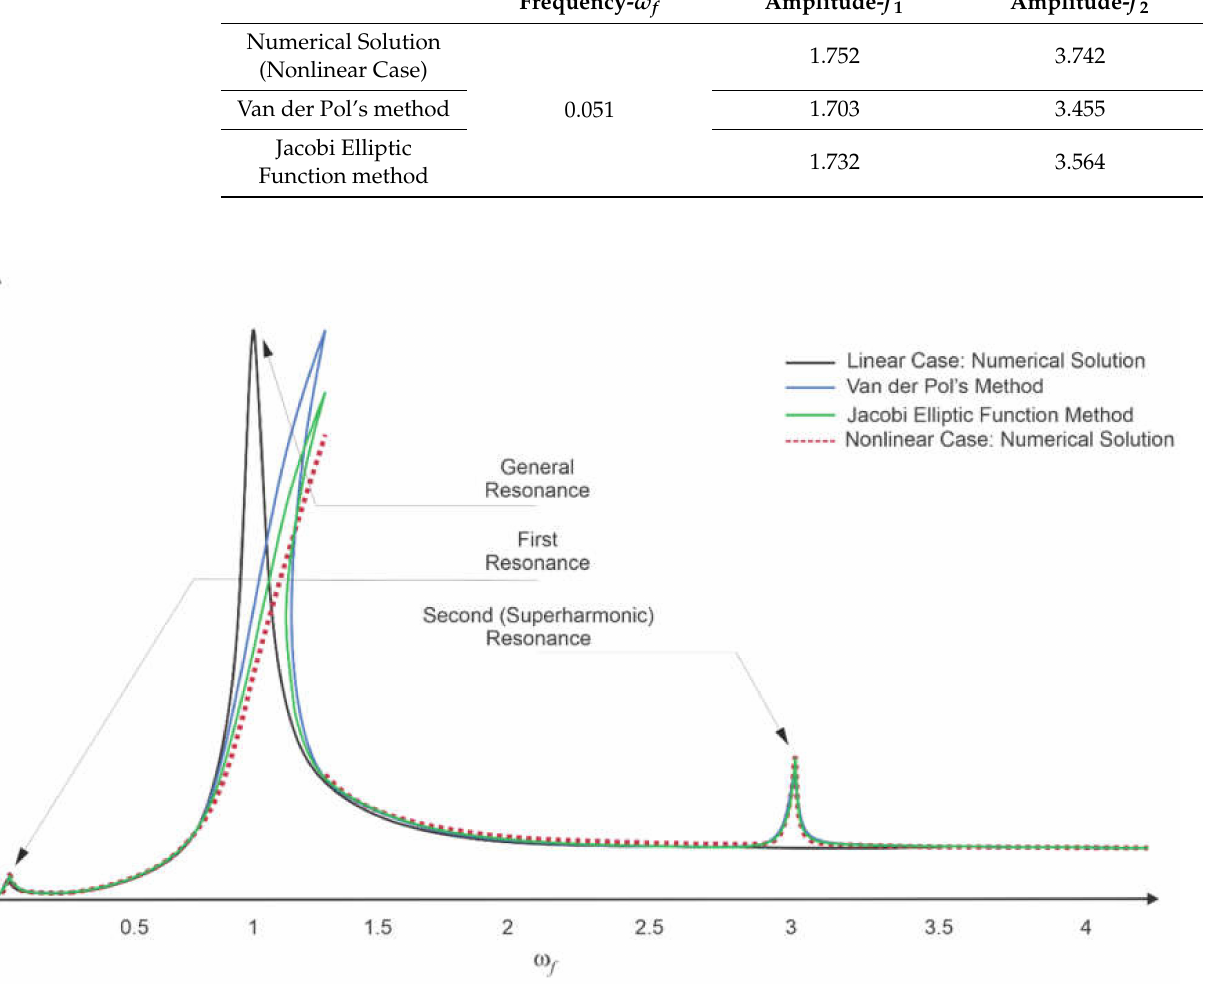
Figure 3. The amplitude-frequency characteristic of the